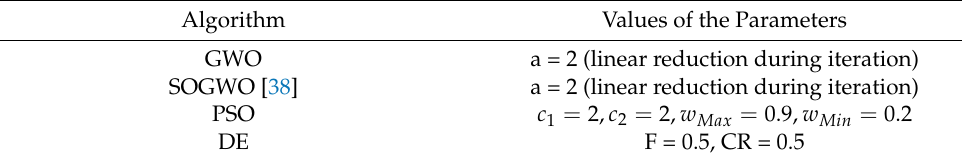
Table 1. Parameter setups of different algorithms.